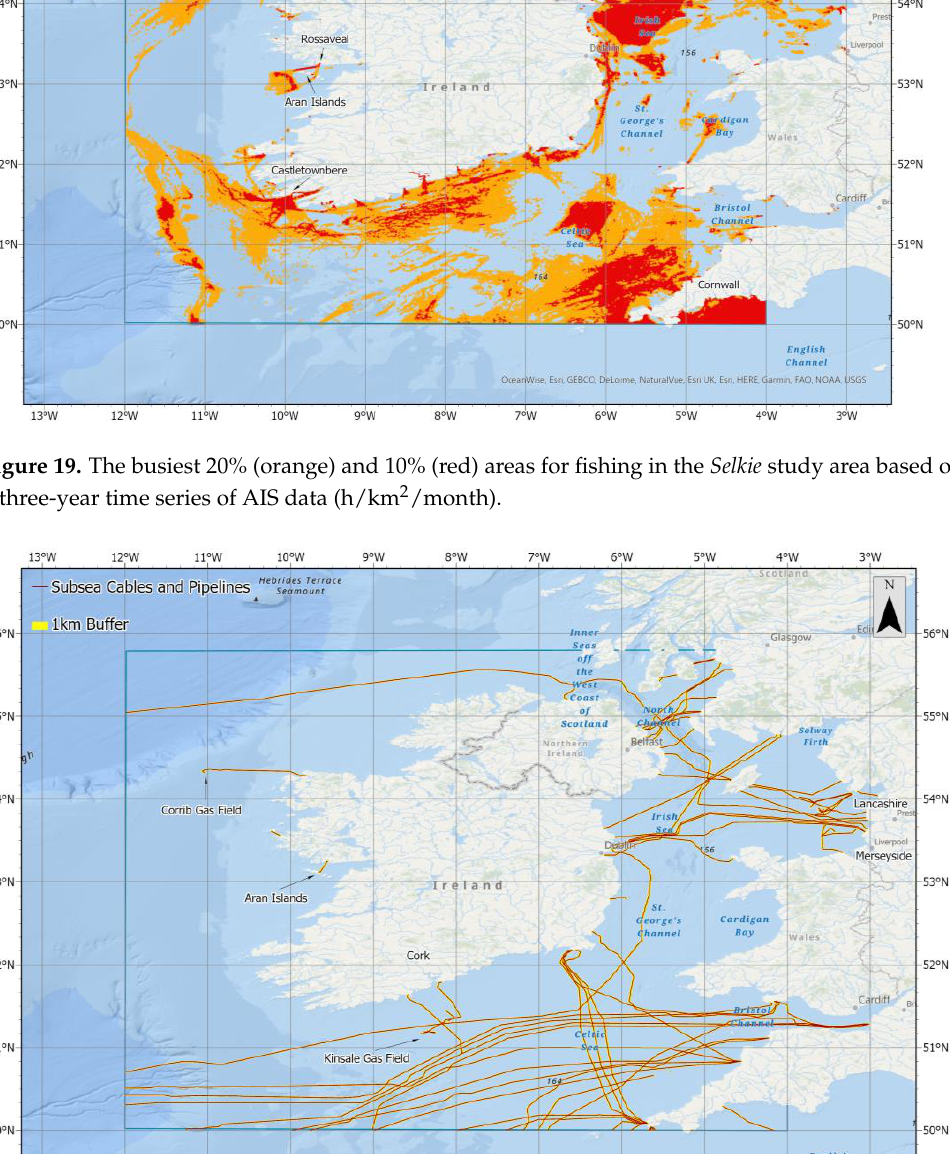
Figure 20. The subsea cable and pipeline infrastructure which run through the study area (red lines) and its associated 1 km buffer zones for exclusion (yellow outline).